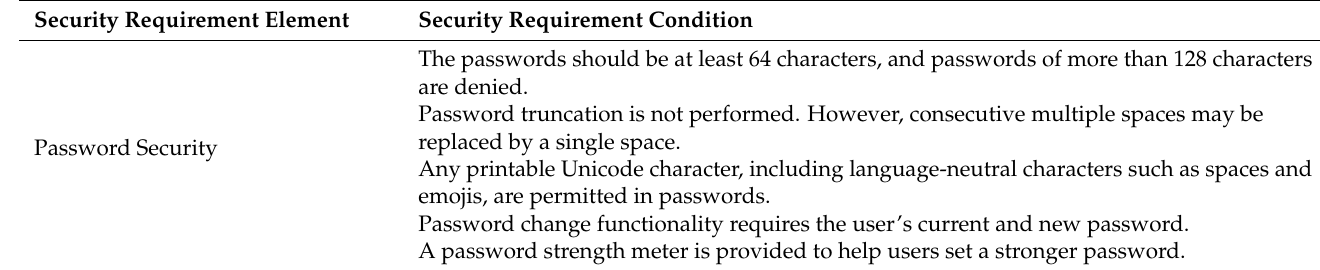
Table 3. Exemplary assurance conditions (security requirement